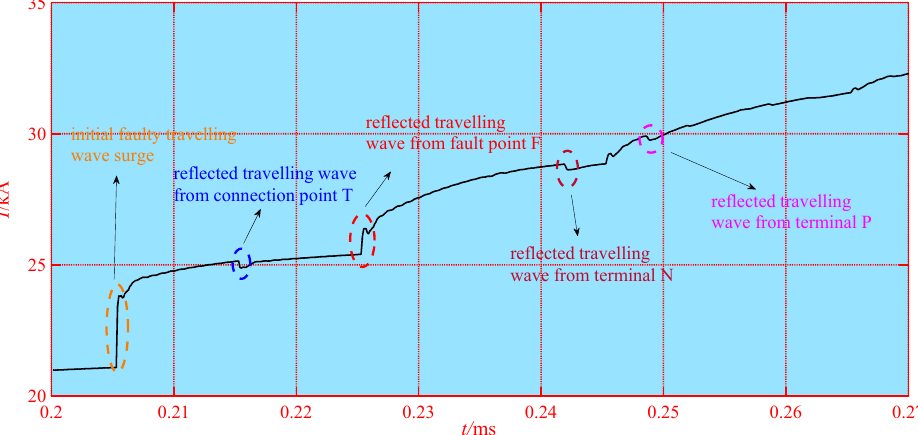
Figure 11. Travelling wave arrive sequence.